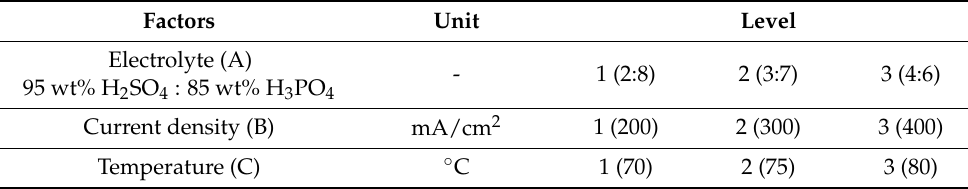
Table 2. Designed control factors and levels of UNS